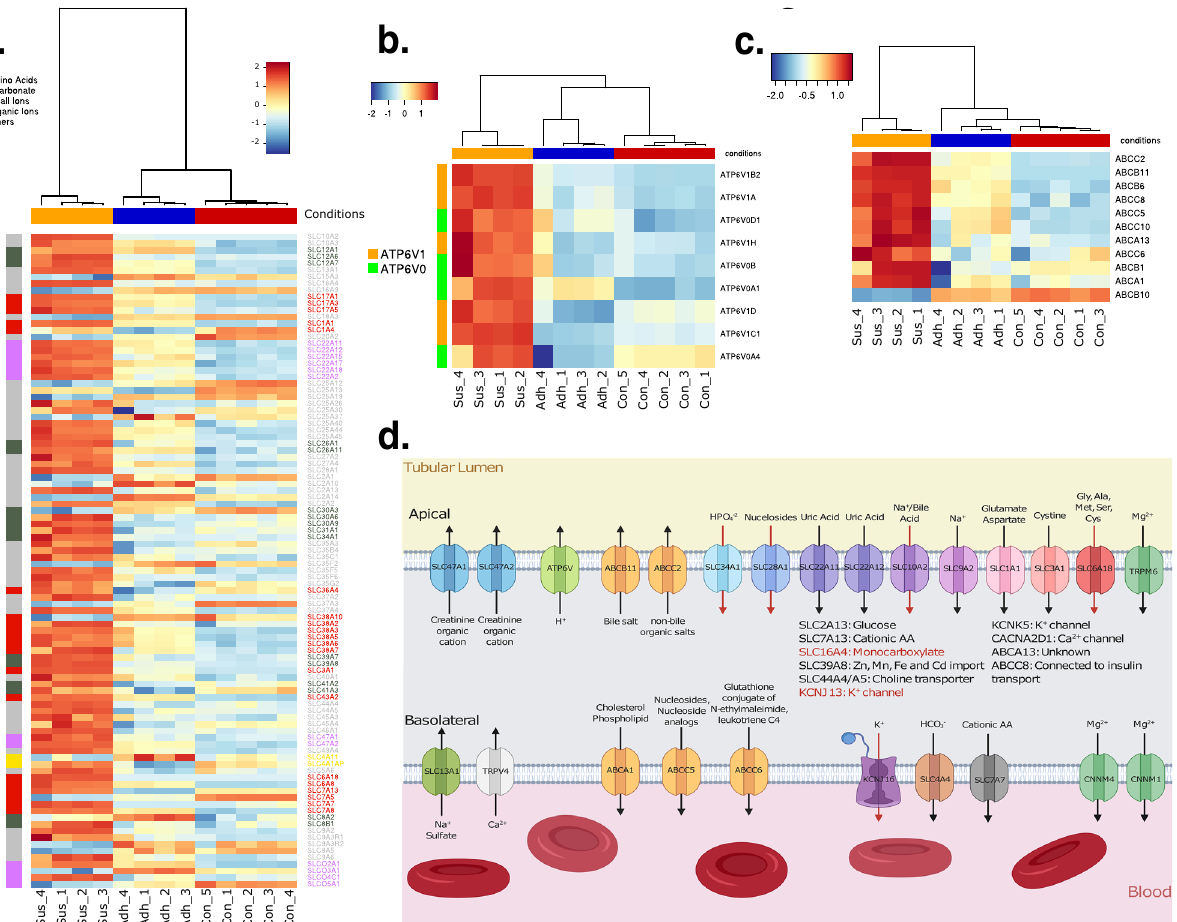
Figure 7. ( a ) heatmap of differentially regulated solute carrier. ( b ) heatmap of differentially regulated subunits of V-type proton ATP (ATP6V). ( c ) heatmap of differentially regulated ABC-transporter. ( d ) Scheme of the significantly up regulated membrane transporter with the target molecules and the direction of transport in a nephron. The transporters whose location are unknown are mentioned in the center of the image. Red colored arrows or gene names indicate an LFC > 5 (Created with Biorender.com).